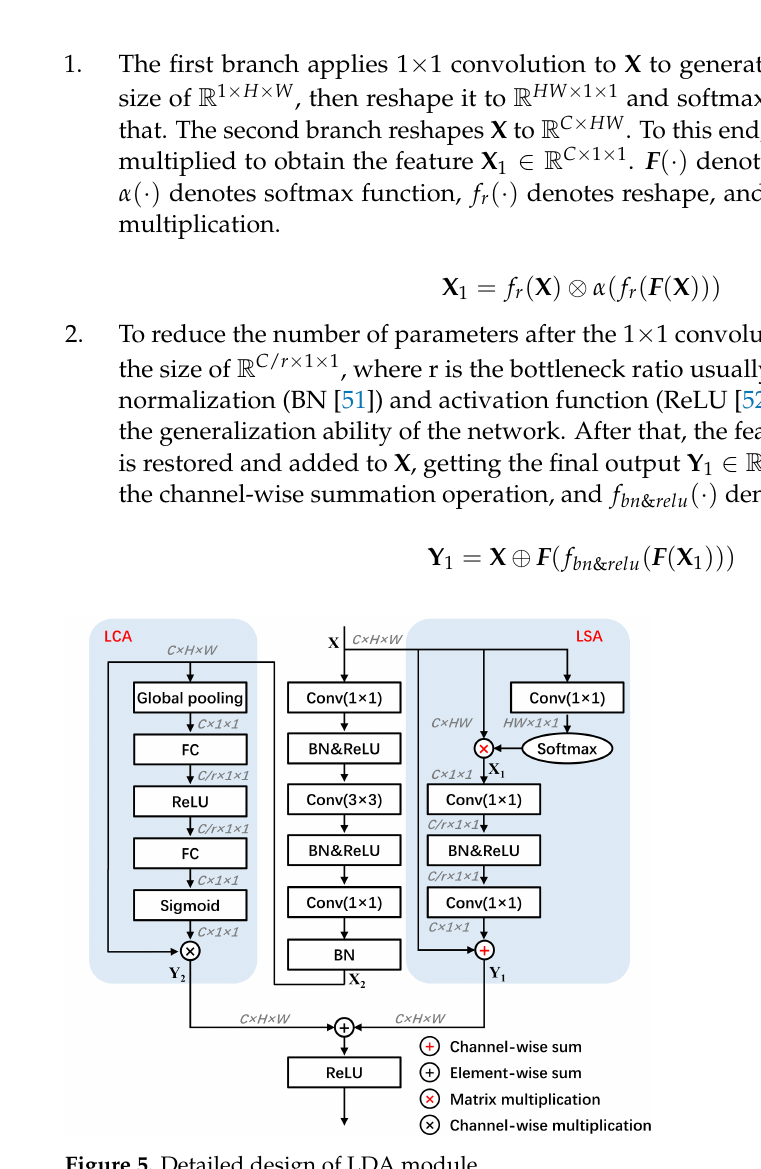
Figure 5. Detailed design of LDA